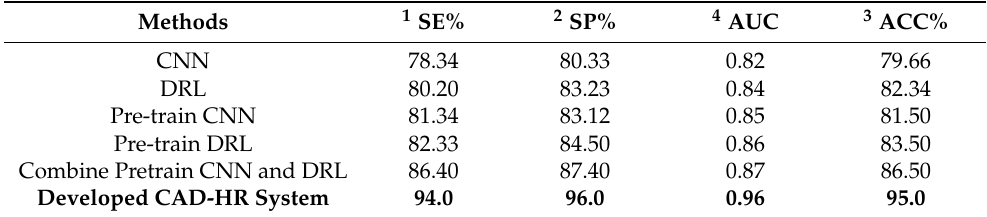
Table 6. Assessment of the efficiency of the developed CAD-HR system vs other deep learning sys- tems on 9500 samples.